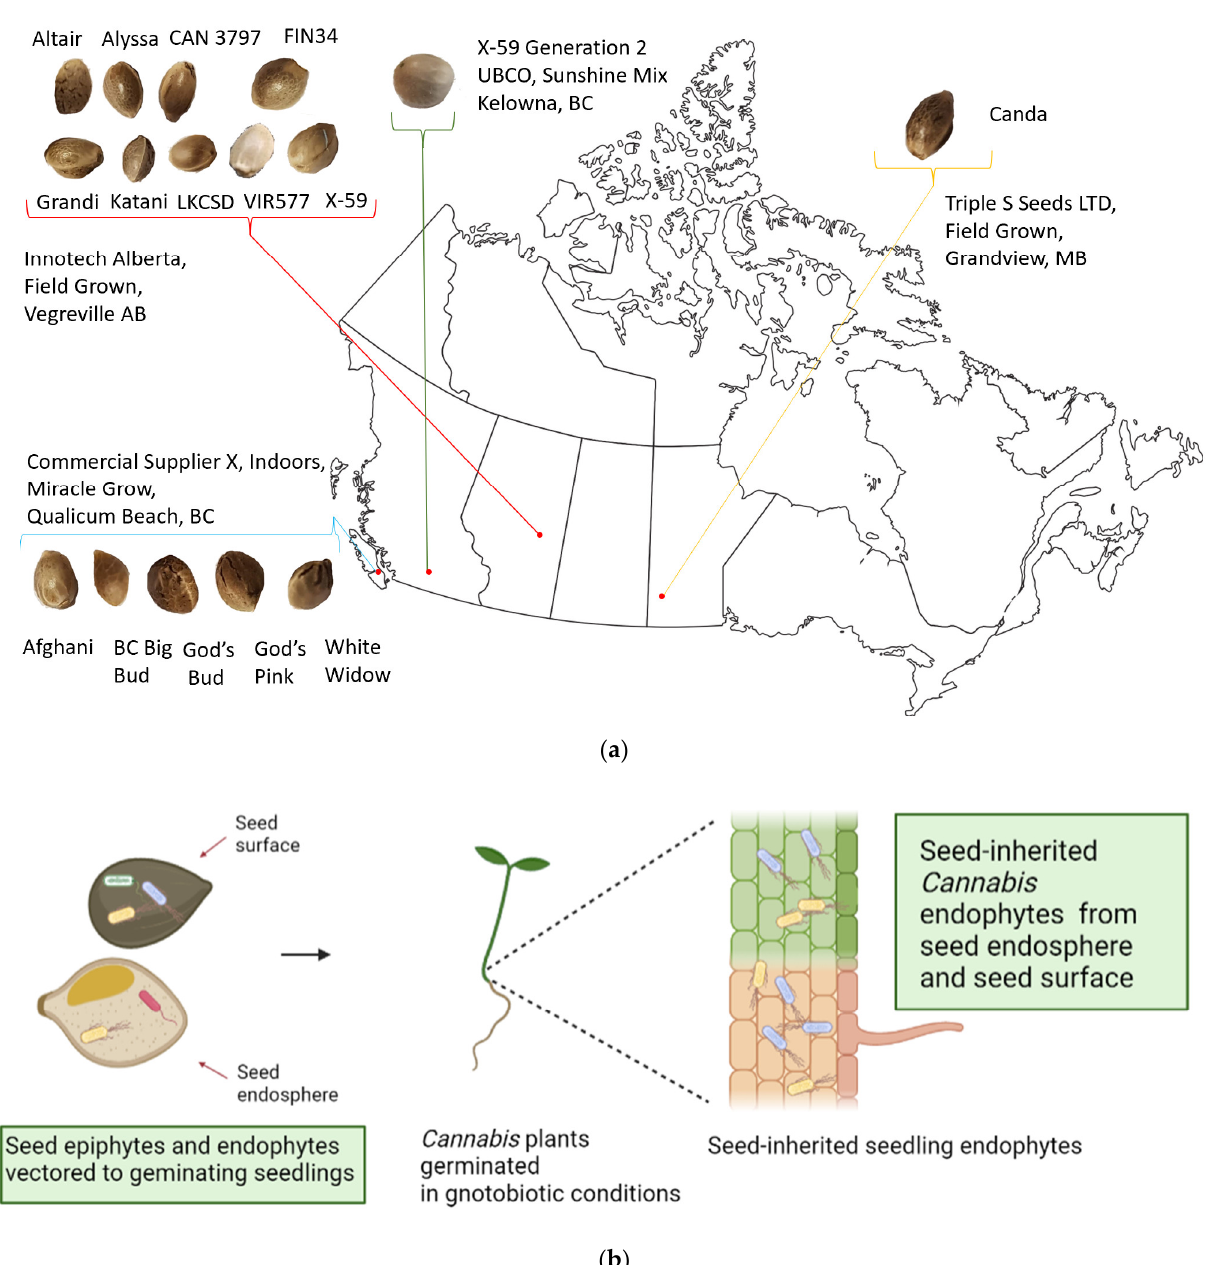
Figure 1. ( a ) Geographic origin of parental Cannabis sativa accessions used for seed in this study. All experiments were performed at UBCO (Kelowna, BC, Canada). ( b ) Schematic for the location and isolation of seedling endophytes in this study. Both seed surface and seed endosphere contribute to seed-borne microbiome. Figure 1b was created with BioRender.com.